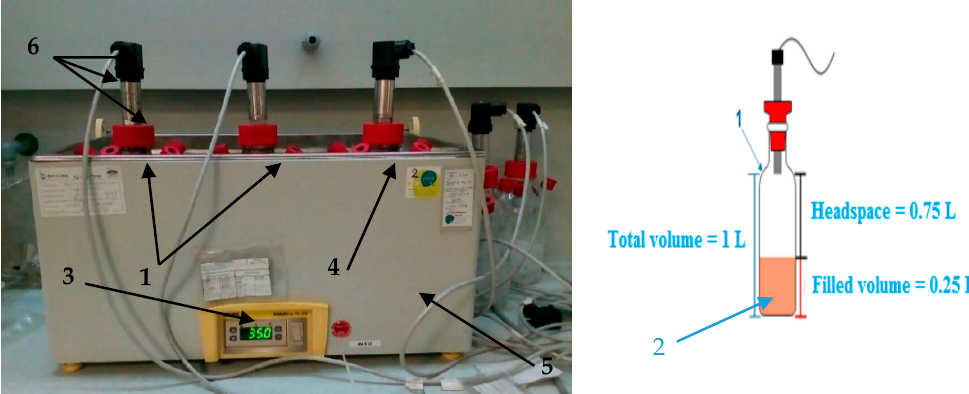
Figure 1. Schematic diagram of the present experiment study; 1—bioreactors, 2—mixture of wastes, 3—temperature display, 4—blank bioreactor, 5—thermostatic bath, 6—pressure sensor compositions .